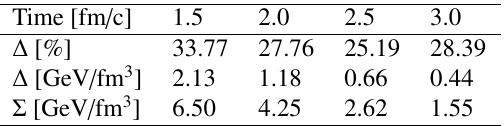
Table 1. A measure of the discrepancy in the energy density distribution between the conditions generated from single event and averaging of 100 event along the x axis for y = z = 12.8